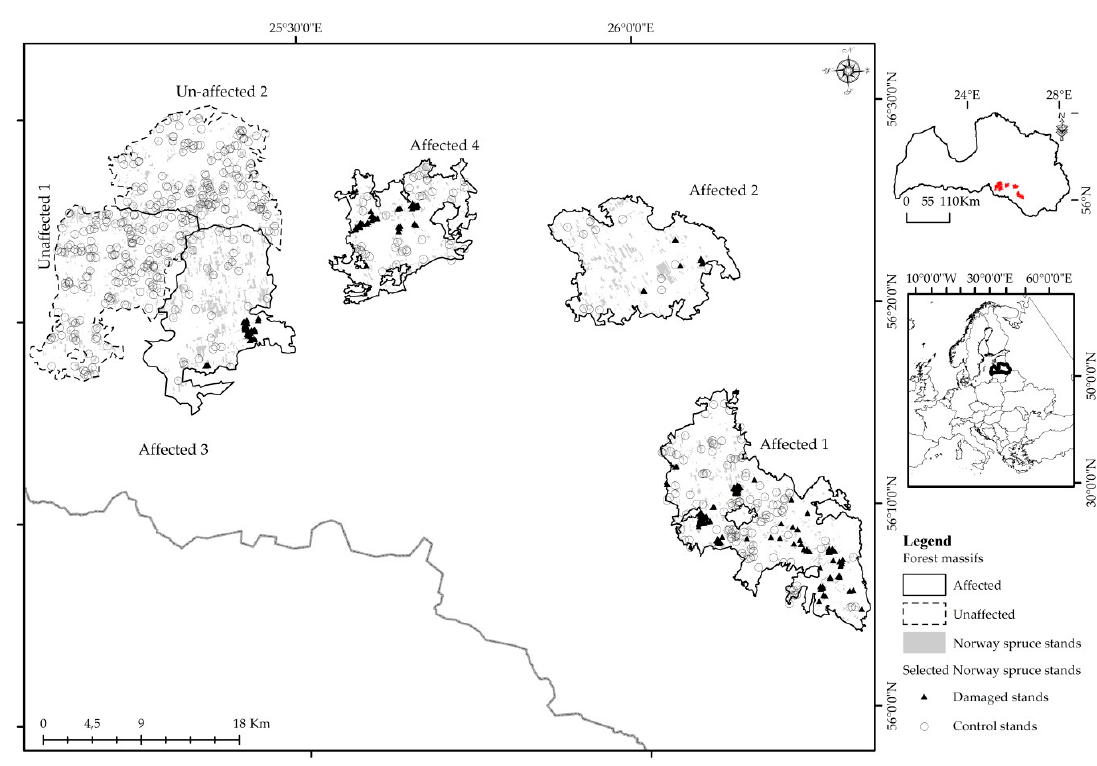
Figure 1. Locations of selected forest massifs in Latvia and spatial distribution of P. piceae (Schrnk.) affected stands.